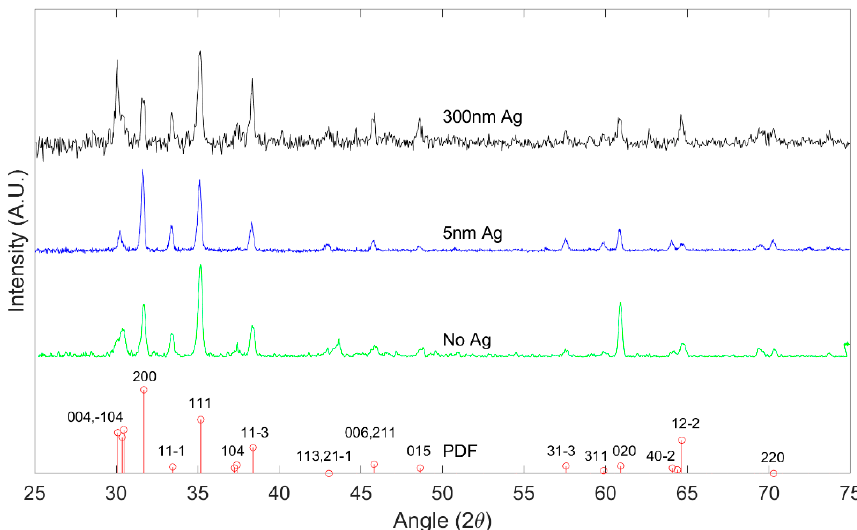
Figure 2. X-ray diffraction (XRD) pattern of β -Ga 2 O 3 for different Ag thickness at 1000 °C, indexed in comparison to PDF 00-041-1103.